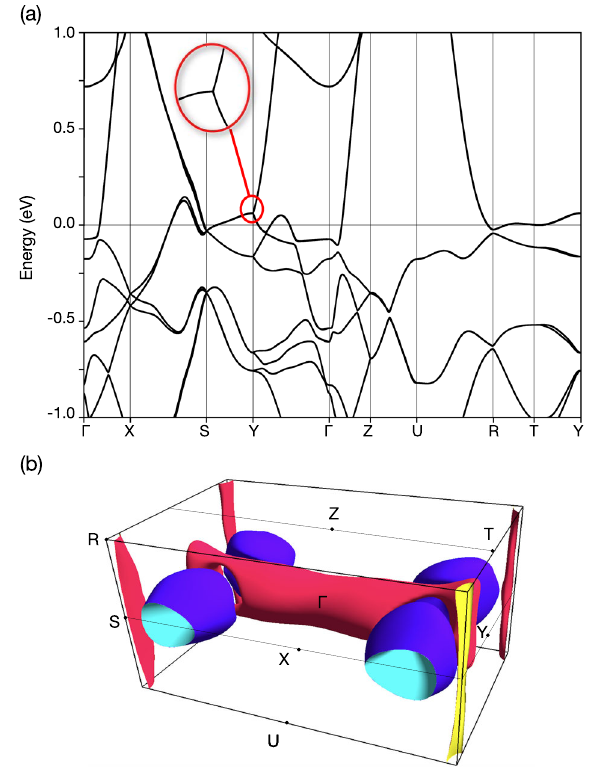
Fig. 5 Density functional theory results for FeP. a Electronic structure of FeP calculated along high-symmetry lines labeled in ( b ). The zoom shows the semi-Dirac point near 71 meV. b Calculated Fermi surface including all eight bands that cross E F